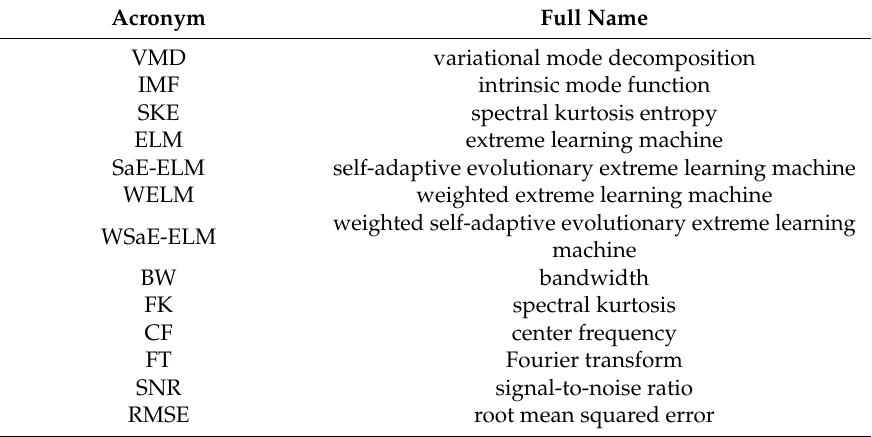
Table 1. The list of